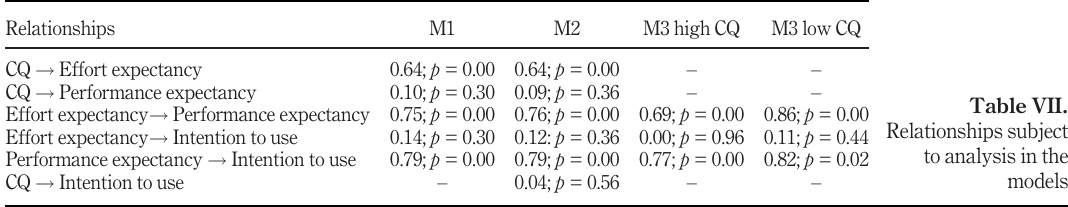
Table VI. Fit indices